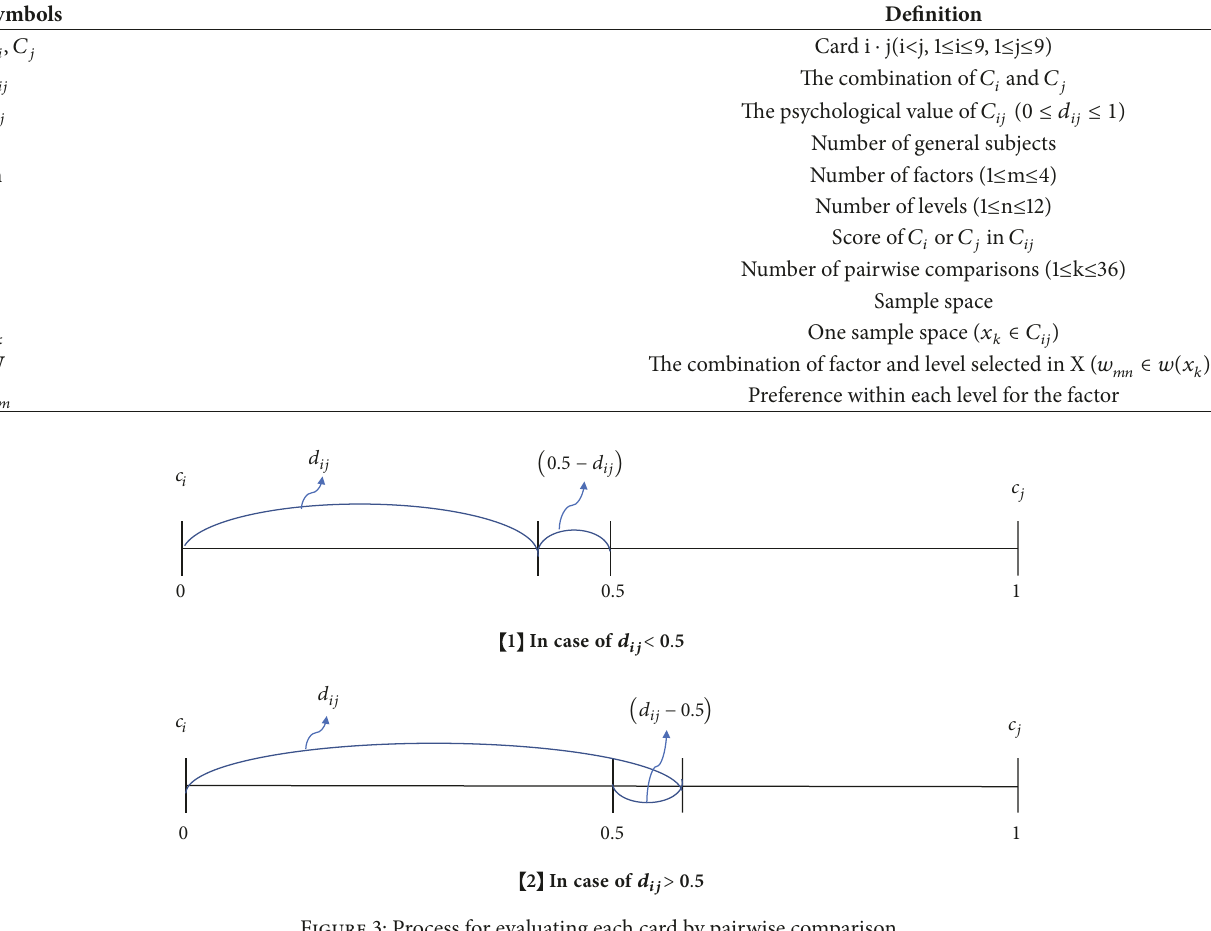
Figure 3: Process for evaluating each card by pairwise